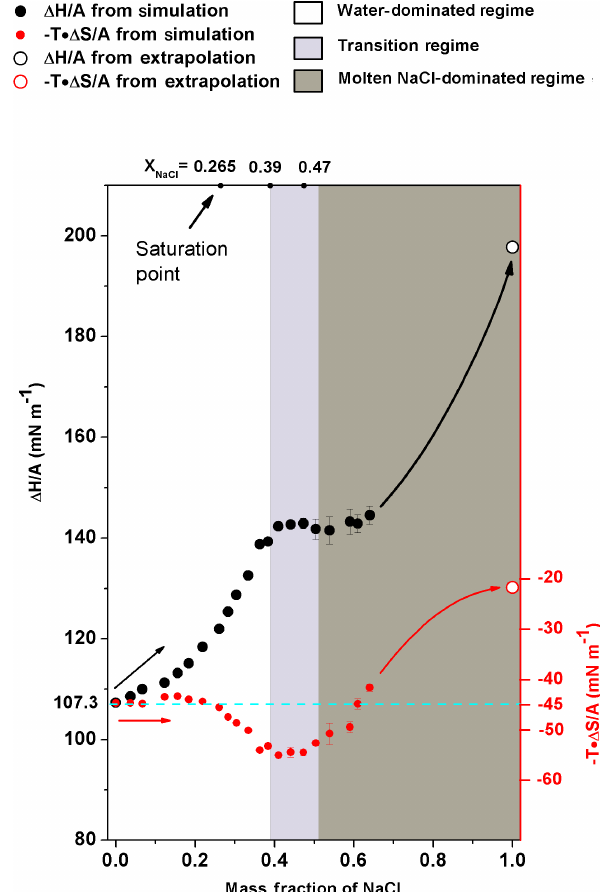
Figure 6. The excess surface enthalpy and entropy per unit area and T · (cid:49)S ) of different NaCl solution concentrations. (cid:49)H ( (cid:49)H A A (black circles) and − T · (cid:49)S (red circles) are shown as a function A of mass fraction of NaCl. The solid circles are obtained from simu- lation directly, and the open circles are obtained from the extrapola- tion of corresponding properties of molten NaCl. The cyan dashed line is only an auxiliary line for clearer view. Shaded areas are the same as in Fig.